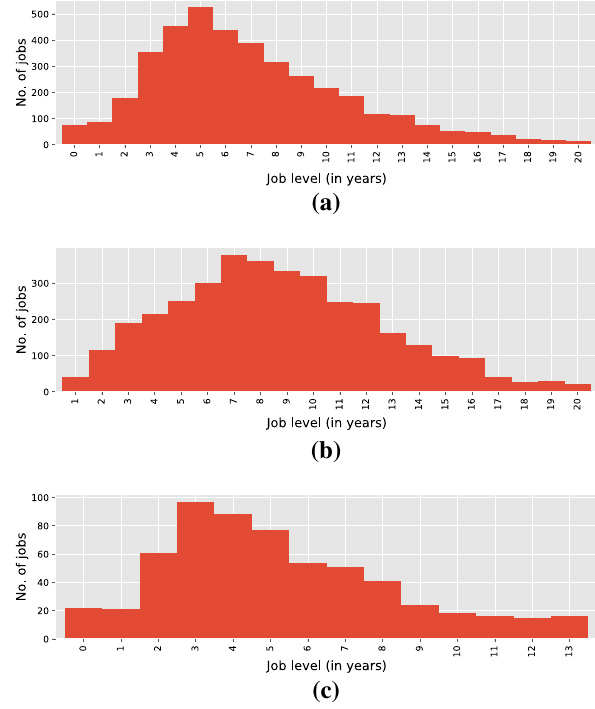
Fig. 7 Distribution of job level. a Singapore. b Switzerland. c Hong Kong